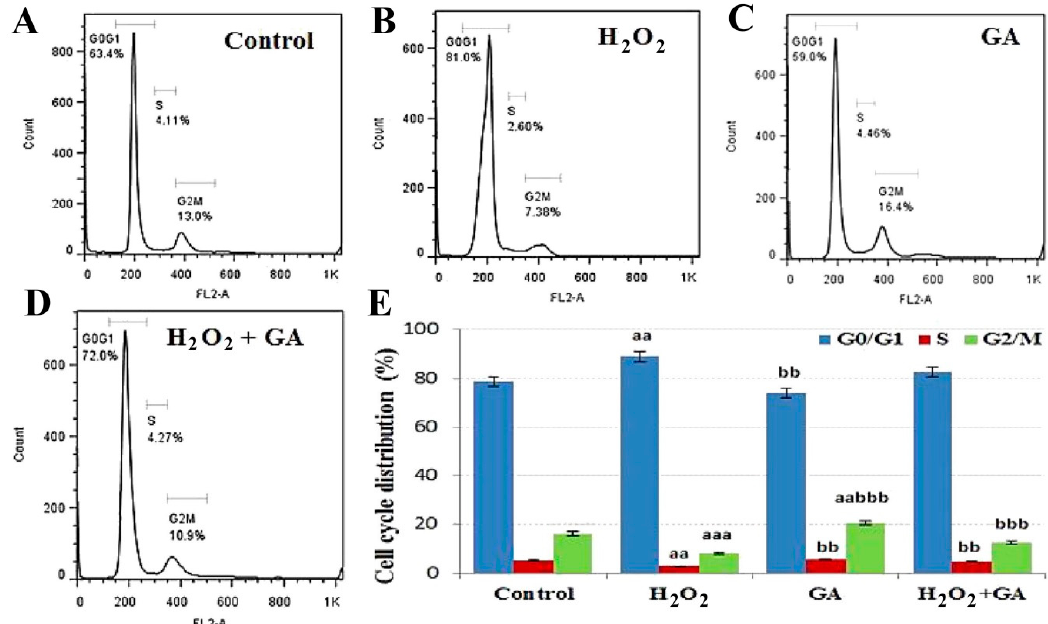
Figure 3. Cell cycle distribution is shown in the presence of control ( A ), H 2 O 2 ( B ), gallic acid (GA) ( C ), and H 2 O 2 + GA ( D ). The percentage of cells in different phases is shown in graph ( E ). Data are presented as the mean ± standard error of measurements performed on six groups, with three independent replicates. Significant difference from control ( aa p < 0.01, aaa p < 0.001), significant difference from H 2 O 2 ( bb p < 0.01, bbb p < 0.001).